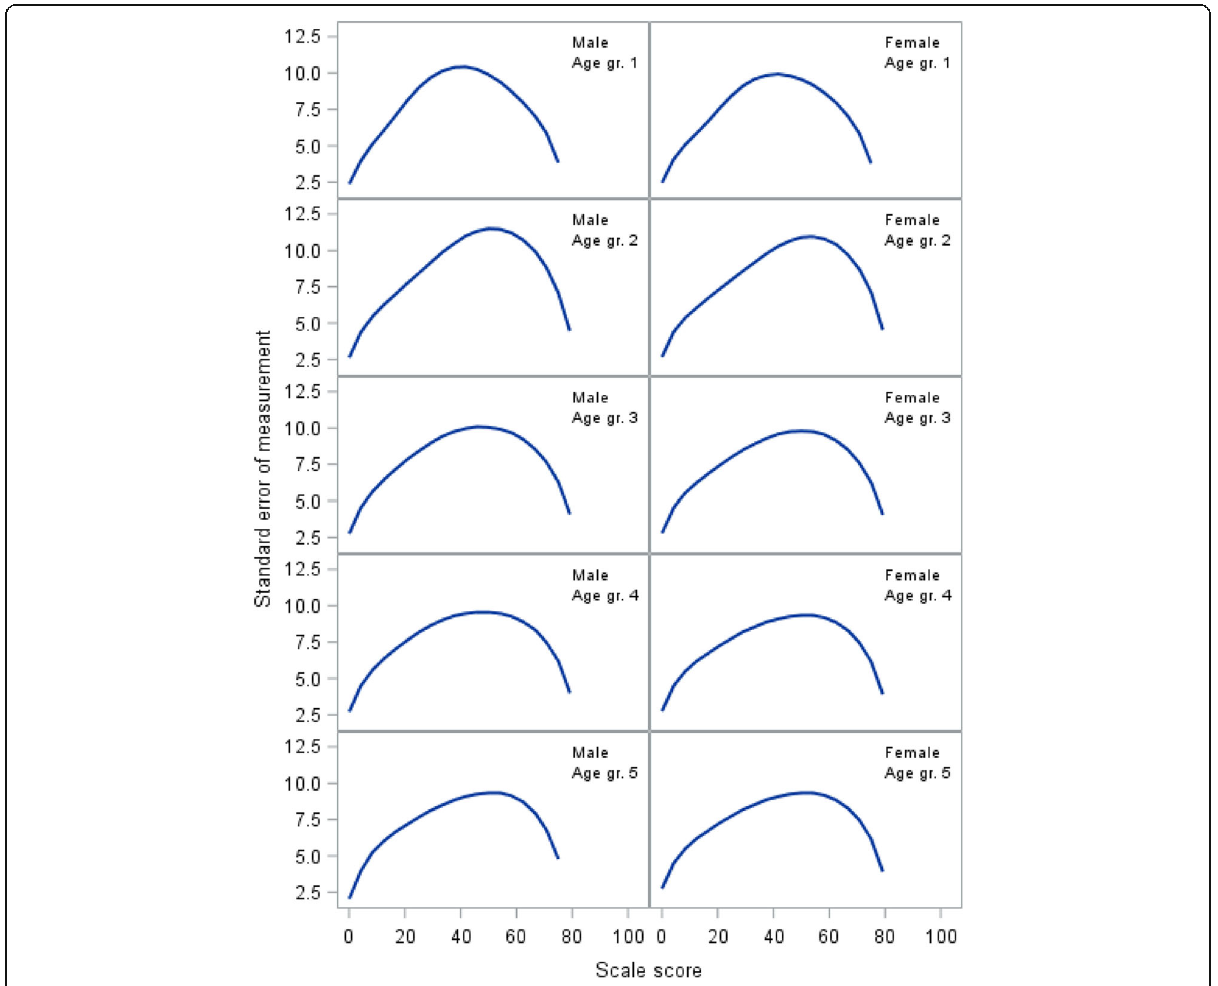
Fig. 5 Standard error of measurement for the Relationship with Children domain